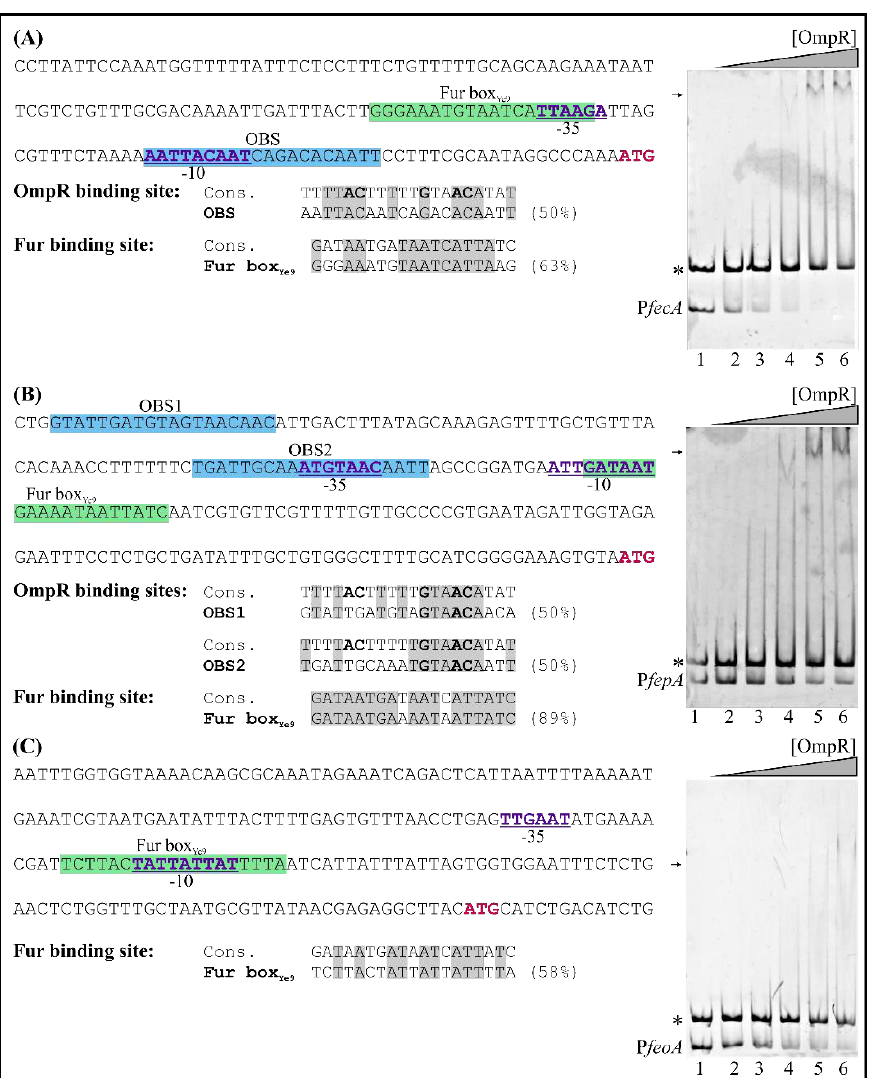
Figure 11. Binding of OmpR-His 6 to the fecA , fepA and feoA regulatory regions examined using EMSAs. Left panels show the promoter of fecA ( A ) from −159 to +3 nt relative to the ATG start codon, fepA ( B ) from −213 to +3 nt relative to the ATG start codon and feoA ( C ) from −200 to +16 nt relative to the ATG start codon, while right panels are the results of EMSA experiments. The sequences shaded blue correspond to the putative OmpR-binding sites. The potential Fur-binding site (Fur box Ye9 ) is highlighted by a green background. The fecA , fepA and feoA start codons (ATG) are shown in bold and marked pink. Beneath the sequence, the putative binding sites are compared with the consensus OmpR and Fur-binding motifs of E. coli . The percentage identity to these sequences is shown. Identical nucleotides in the compared sequences are shaded gray. Nucleotides important for OmpR binding are in bold. The P fecA (189 bp), P fepA (247 bp) and P feoA (227 bp) promoter fragments and the 304-bp fragment of 16S rDNA (*, from Y. enterocolitica Ye9) were incubated together in reaction mixtures without protein (lane 1) or with an increasing amount of purified OmpR: 0.6 (lane 2), 1.2 (lane 3), 2.4 (lane 4), 4.8 (lane 5), 6 µM (lane 6). The OmpR/DNA complexes were resolved on a native polyacrylamide gel and detected by SYBR Green staining. Shifted bands containing the fecA / fepA / feoA promoter region are marked by arrows.